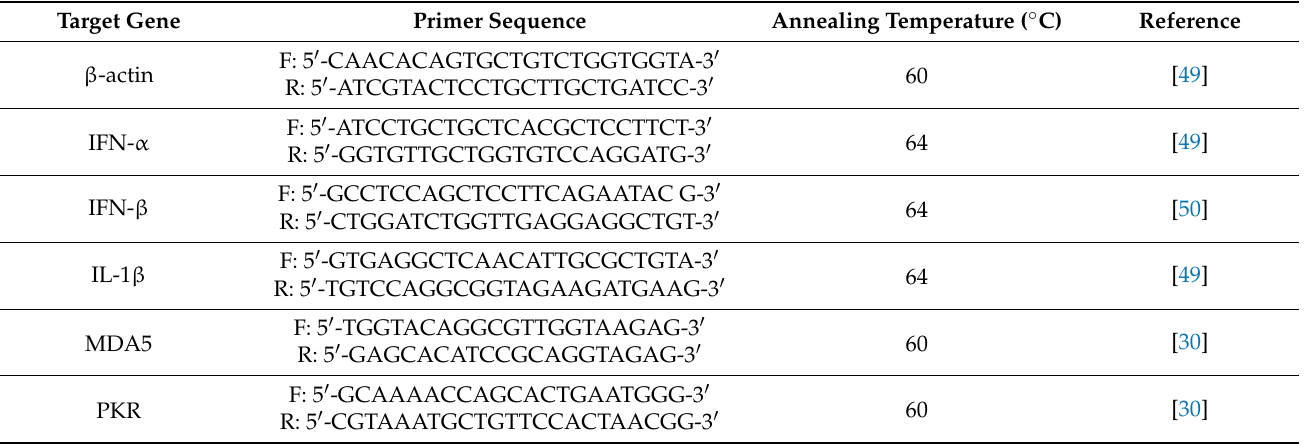
Table 1. Primer sequences used for